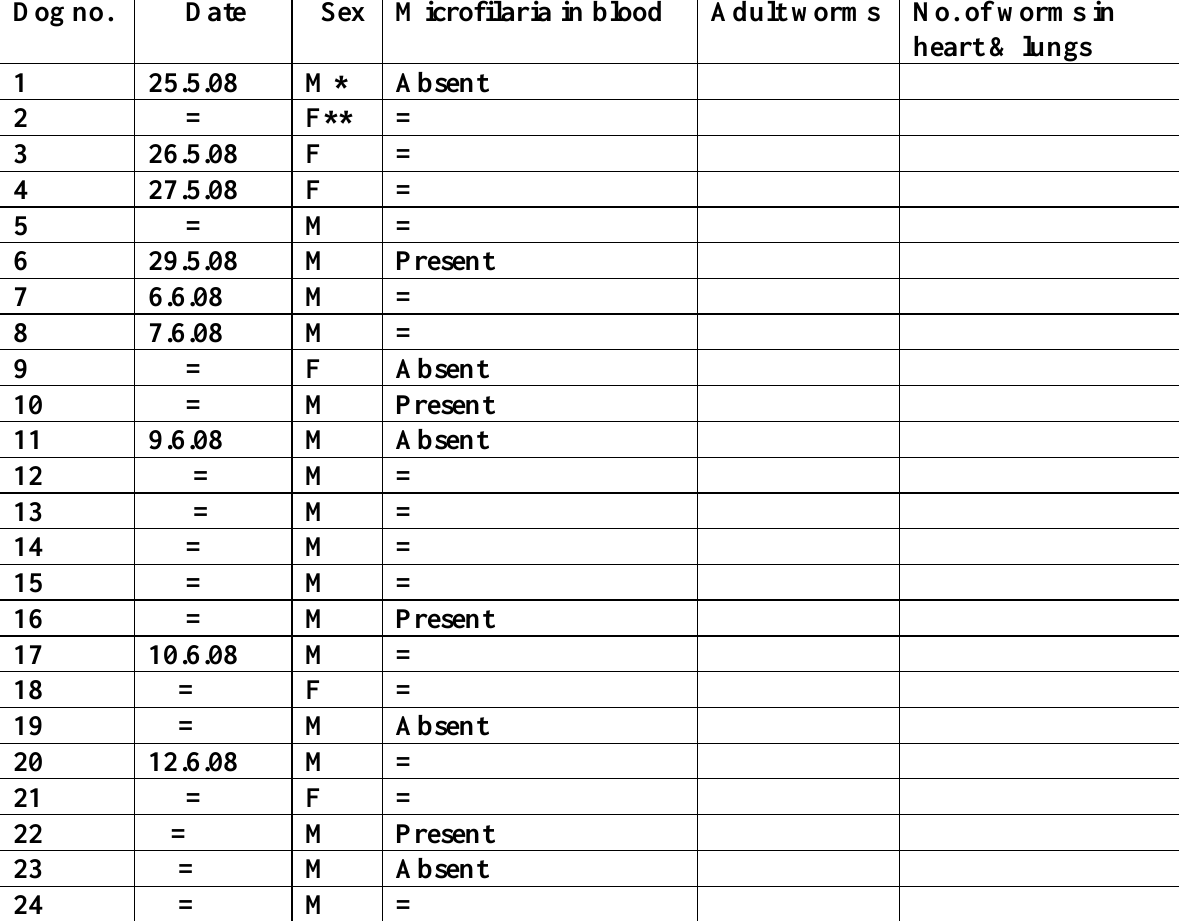
Table(1): prevalence of Dirofilaria immitis infection in 24 dogs from kerbala/Iraq . Dog no. Date Sex Microfilaria in blood Adult worms No. of worms in heart &